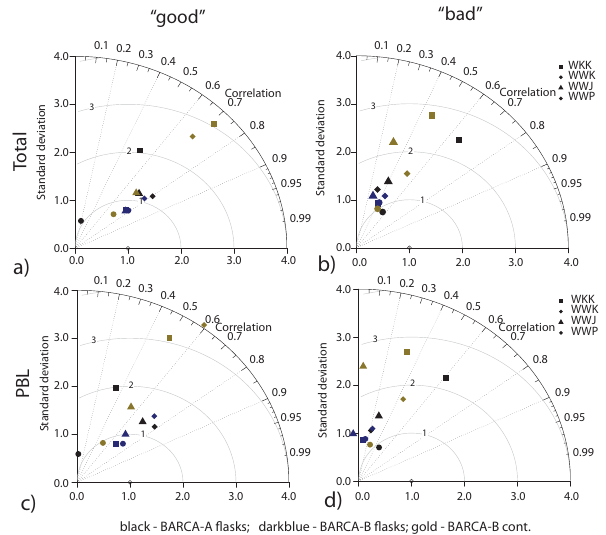
Fig. 7. Taylor diagram illustrating the normalised standard deviation and the Pearson’s correlation coefficient for the comparison of the total CH 4 mixing ratio of the different WRF simulations (BARCA- A flasks – black; BARCA-B flasks – darkblue; BARCA-B cont. ob- servations – gold). They are divided into flights with good weather conditions (a, c) and bad weather conditions (b, d) . Additionally, they are separated in observations at all altitudes (a, b) and obser- vations in the planetary boundary layer (altitudes < 1250 m) only (c, d)